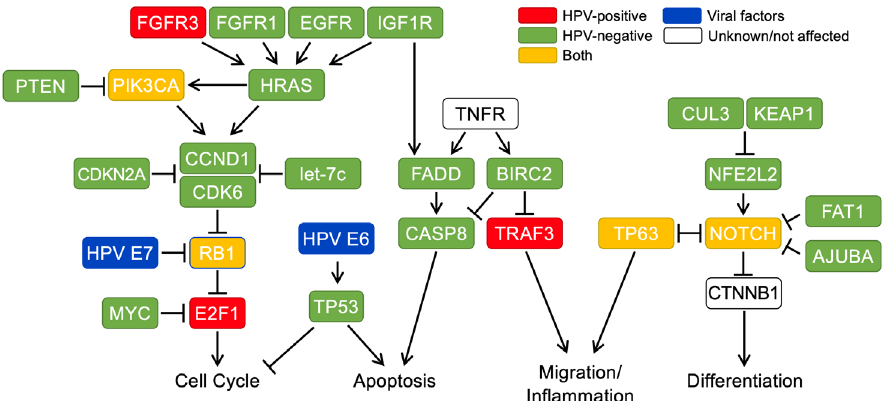
Figure 1. An overview of the key factors and pathways with genome mutations and molecular dysregulations in HPV+ and HPV − HNSCCs [7,10]. Genome mutations and alterations mainly found in HPV+, HPV − , and both HNSCCs are indicated with red, green, and yellow boxes, respectively. The HPV oncogenes E6 and E7 are shown as blue boxes, and unknown or unaffected genes are shown as white boxes. FGFR3, fibroblast growth factor receptor 3; FGFR1, fibroblast growth factor receptor 1; EGFR, epidermal growth factor receptor; IGF1R, insulin like growth factor 1 receptor; PTEN, phosphatase and tensin homolog; PIK3CA, phosphatidylinositol-4,5-bisphosphate 3-kinase catalytic subunit alpha; HRAS, Hras proto-oncogene, GTPase; CCND1, cyclin D1; CDK6, cyclin dependent kinase 6; CDKN2A, cyclin dependent kinase inhibitor 2A; let-7c, microRNA let-7c; RB1, RB transcriptional corepressor 1; MYC, MYC proto-oncogene, BHLH transcription factor; E2F1, E2F transcription factor 1; TP53, tumor protein P53; TNFR, tumor necrosis factor receptor; FADD, fas associated via death domain; CASP8, caspase 8; TRAF3, tumor necrosis factor receptor associated factor 3; CUL3, cullin 3; KEAP1, kelch like ECH associated protein 1; NFE2L2, nuclear factor, erythroid 2 like 2; TP63, tumor protein P63; NOTCH, notch receptor; FAT1, FAT atypical cadherin 1; AJUBA, ajuba LIM protein; CTNNB1, catenin beta 1.